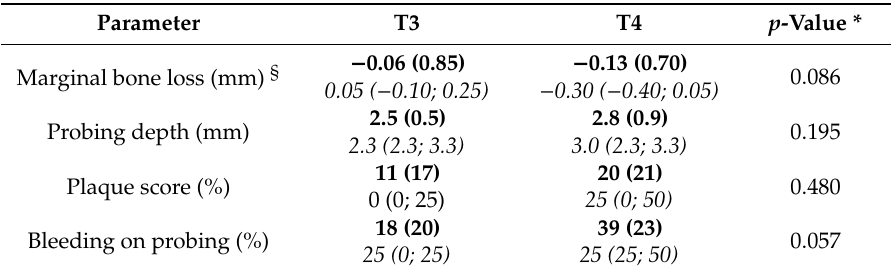
Table 2. Clinical parameters.